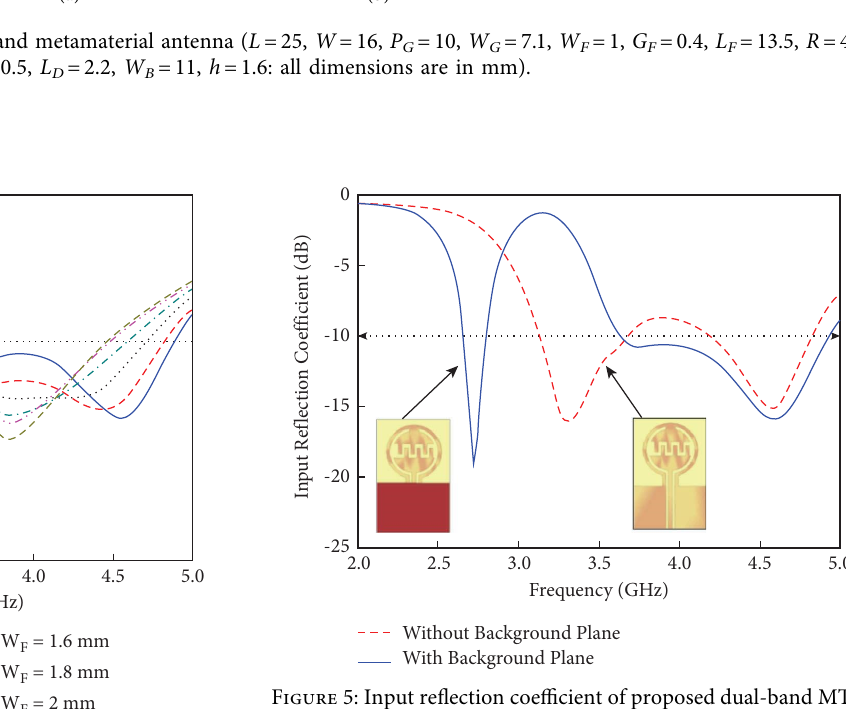
� 10, W � 7.1, W � 1, G � 0.4, L � 13.5, R � 4.5, G G F F F